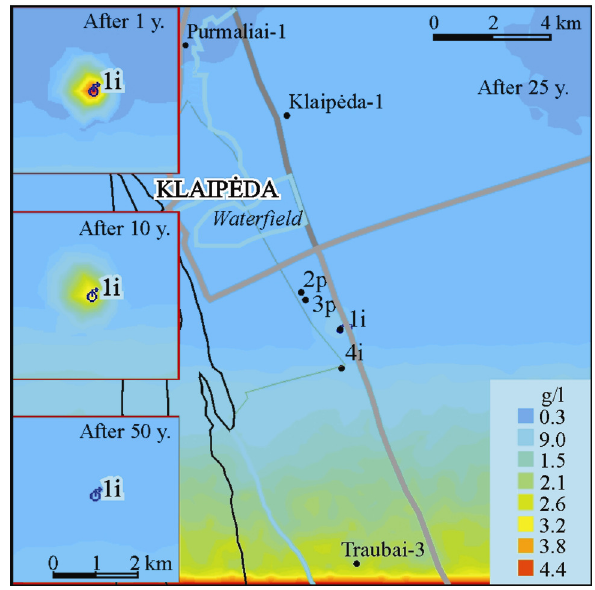
Fig. 9. Mineralization of Upper Permian–Žagarė aquifer water after 1, 10, 25 and 50 years of spent water injection with project yield